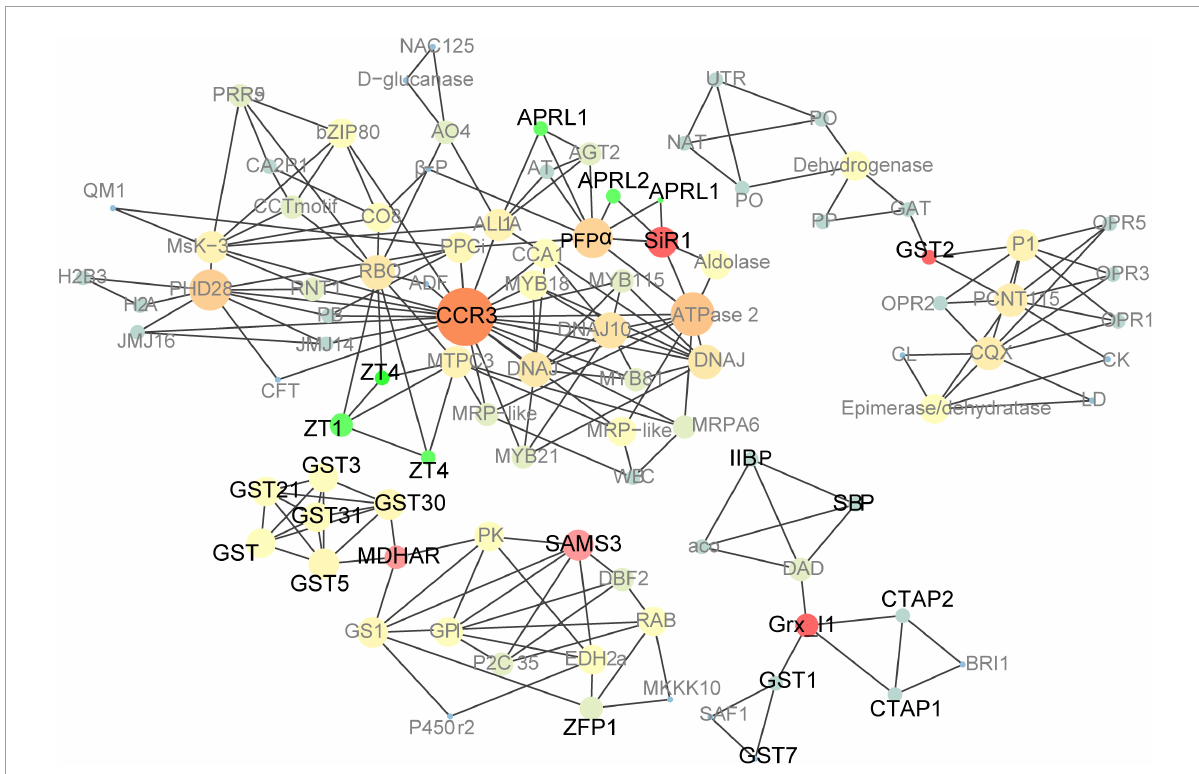
FIGURE6 Co-expression network analysis of up-regulated genes in pRbcS:AtSAT1-pRbcS:EcPAPR mature leaves and 18 DAP endosperm. Cycle nodes represent genes, and the sizes of the nodes represent the power of the interrelation among the nodes. Edges between two nodes represent interactions between genes. The more edges of a gene, the more genes are connected to it, and the more central role it has within the network.